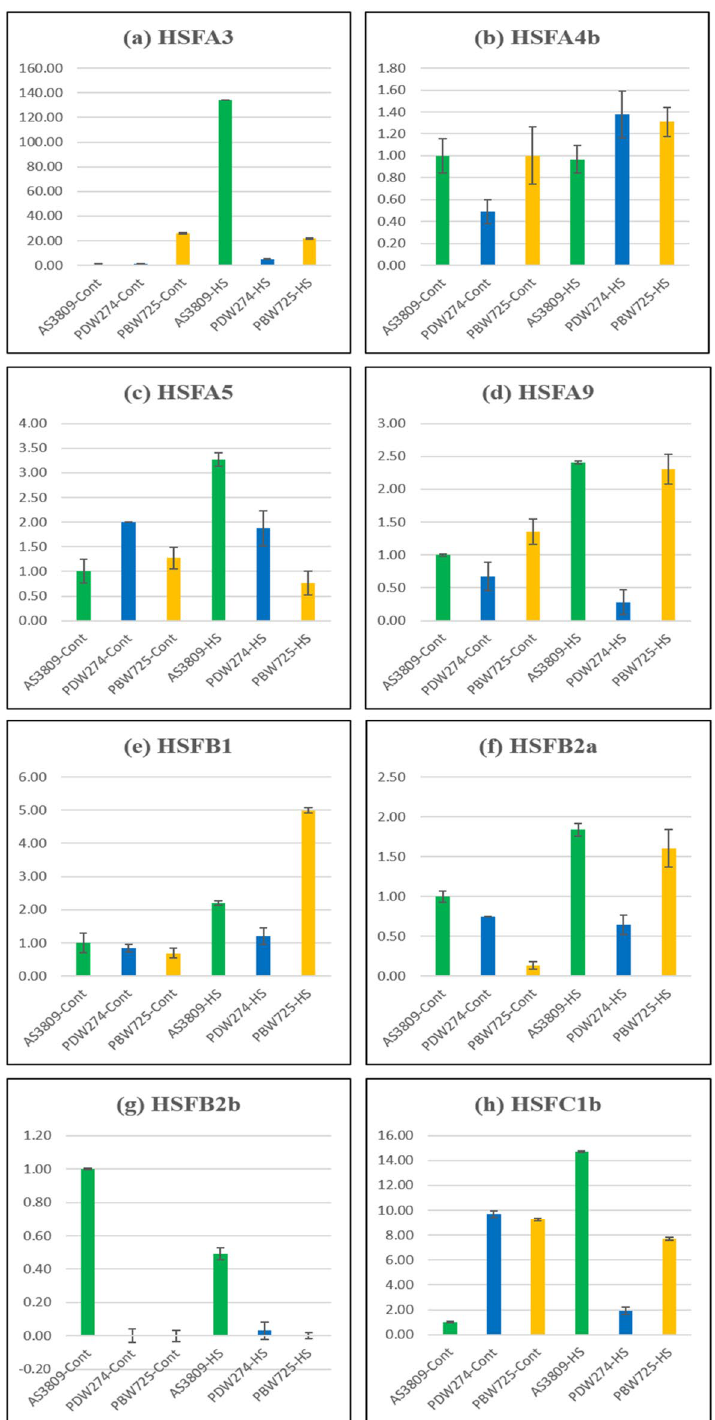
Figure 6. Expression analysis of HSF genes in response to control and high-temperature stress in three species of wheat (AS3809, PBW725, and PDW274). Change in transcript abundance of HSF genes in 10 days old seedlings of wheat species of different ploidy levels subjected to heat stress at 35 °C for 1 h. ( a ) HSFA3 ( b ) HSFA4b ( c ) HSFA5 ( d ) HSFA9 ( e ) HSFB1 ( f ) HSFB2a ( g ) HSFB2b ( h ) HSFC1b . The expression level at control (AS3809) i.e., 0 h of treatment was normalized as 1.0. The results shown are the means ± SE of three independent